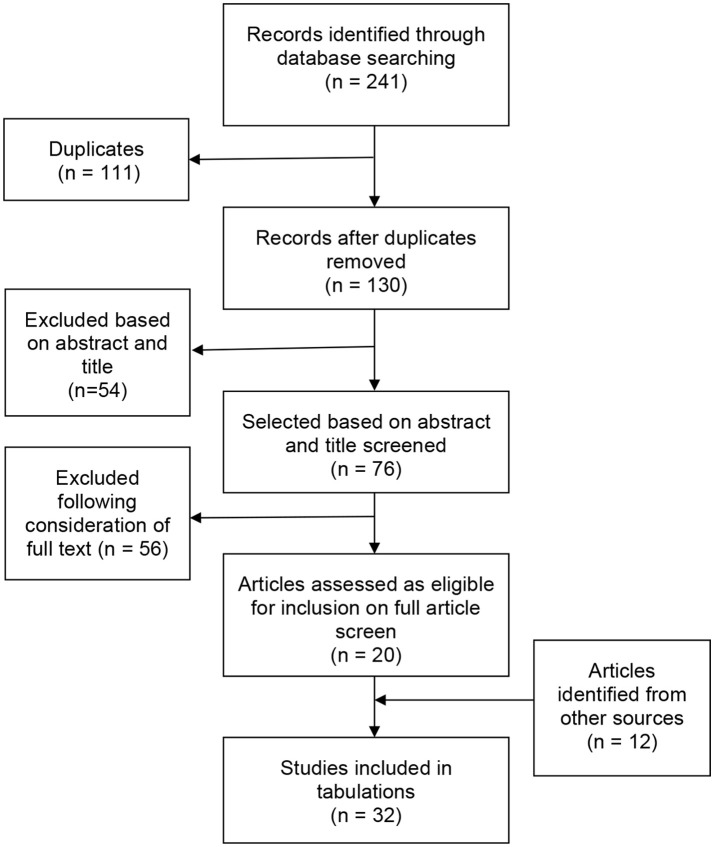
Flowchart of study identification.